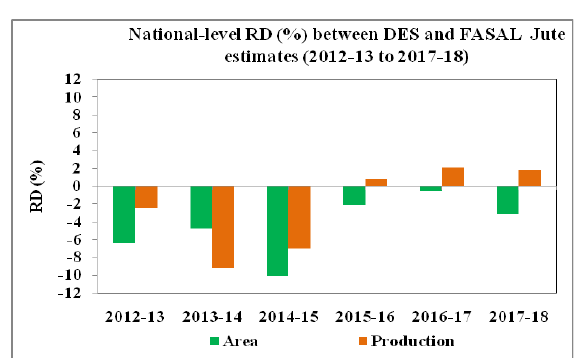
Figure 11. National level RD (%) comparison over the years 4.2 National Relative Deviation (%) comparison between DES and FASAL estimates over the